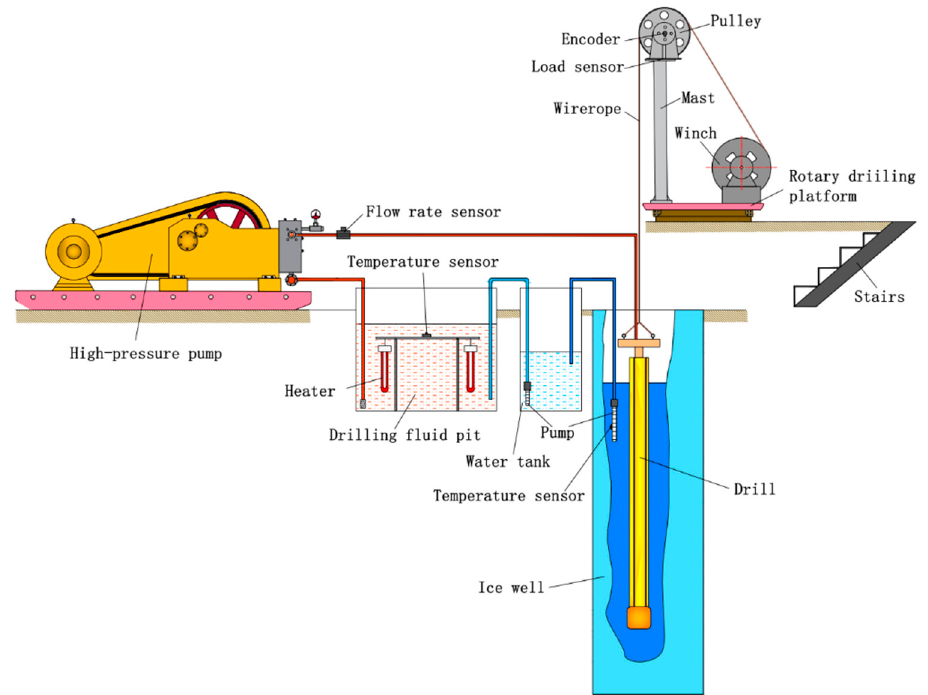
Figure 6. Schematic of testing hot water ice-coring drill.